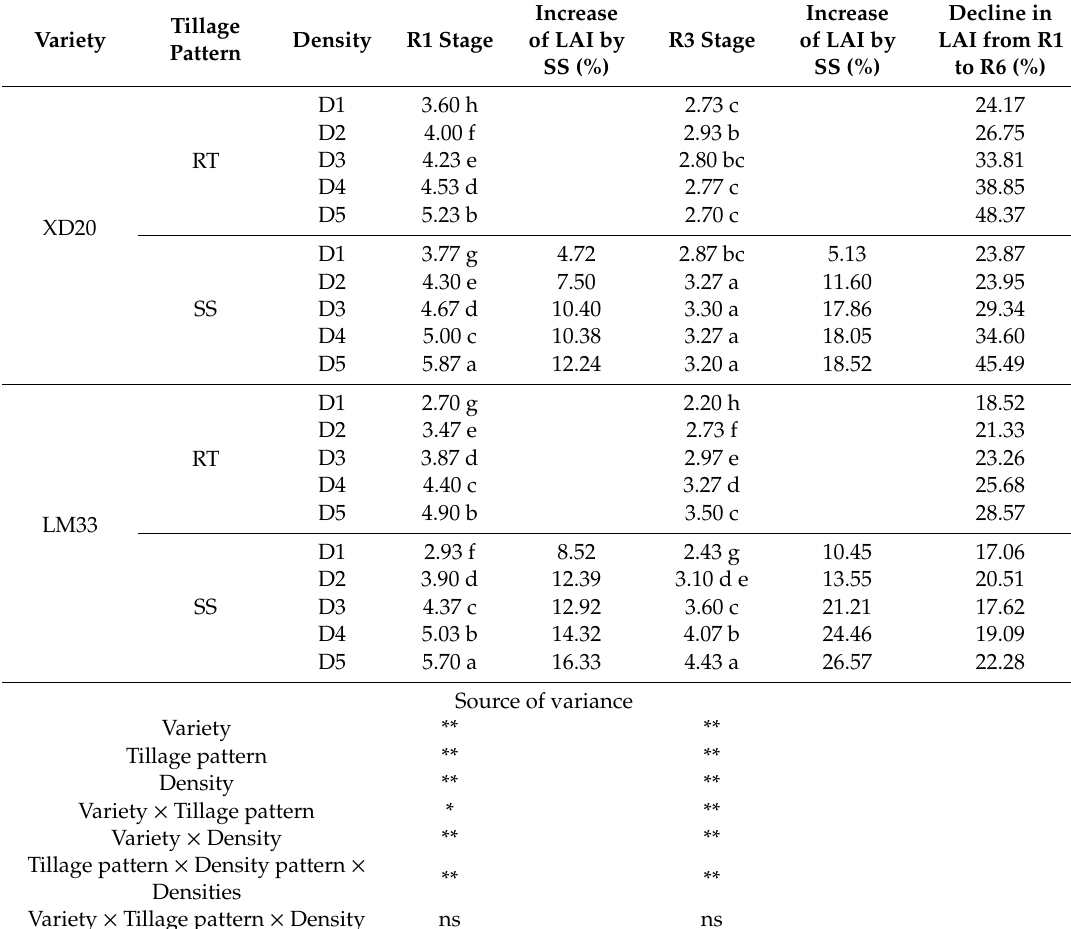
Table 3. Leaf area index (LAI) of di ff erent high-yielding spring maize varieties under di ff erent tillage methods and planting